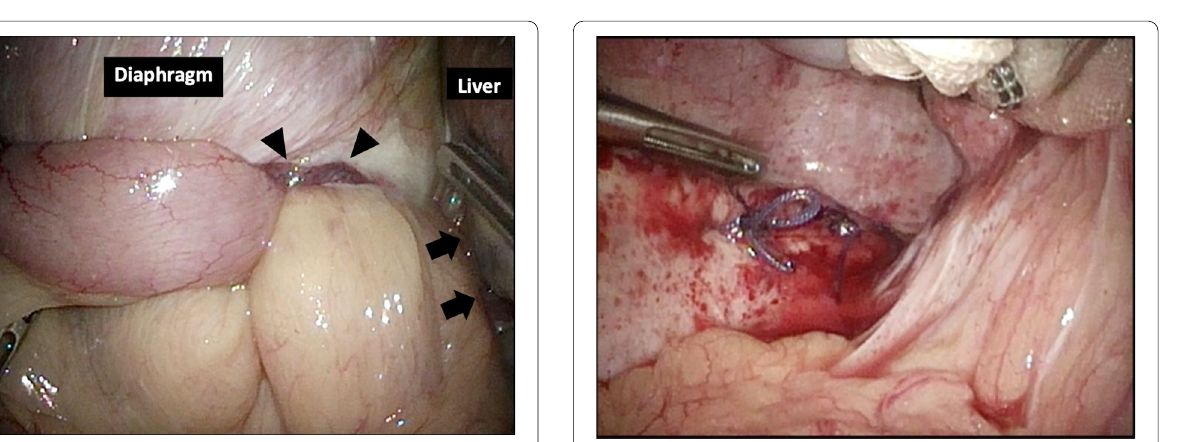
Fig. 5 Simple suture repair of the